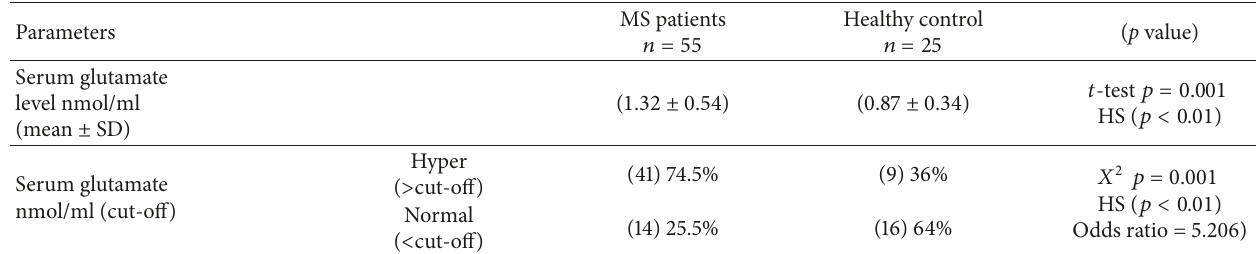
Table 2: Comparison between MS patients and controls using the serum glutamate concentration (nmol/ml).